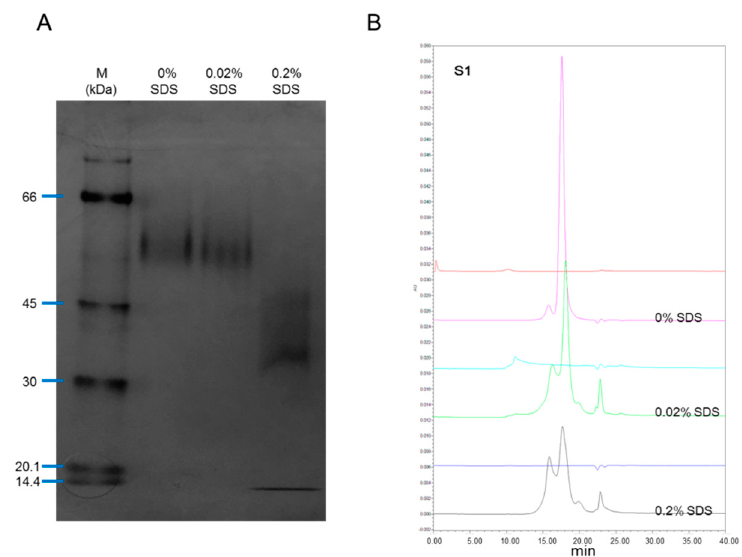
Figure 2. Effect of SDS on rhIL-12 pattern in native PAGE and SEC-HPLC. The rhIL-12 bulk S01 was treated by 0%, 0.02% and 0.2% SDS before analysis. ( A ) Native PAGE. ( B ) SEC-HPLC.